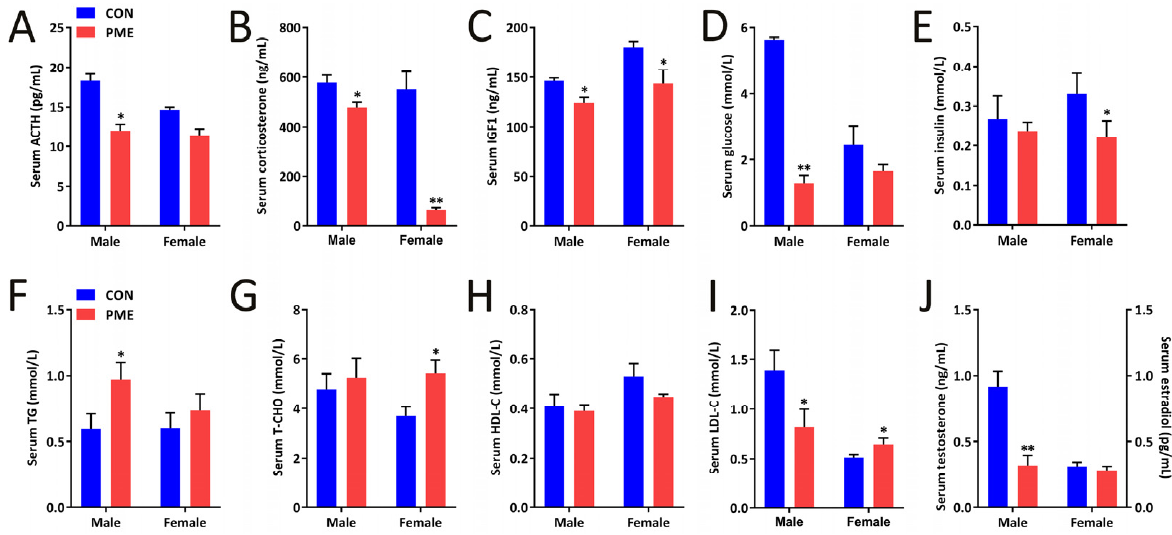
Figure 5. Impairments of paternal mixed exposure (PME) on HPA axis activity, glucolipid metabolism, and sex hormone levels in offspring. ( A ) Serum ACTH content. ( B ) Serum corticosterone content. ( C ) Serum IGF1 content. ( D – I ) Levels of serum glucolipid metabolism indicators, including glucose ( D ), insulin ( E ), TG ( F ), T-CHO ( G ), HDL-c ( H ), and LDL-c ( I ). ( J ) Serum testosterone and estradiol contents. Means ± S.E.M., n = 10 * p < 0.05, ** p < 0.01 vs. CON (control). Table 1. Correlation analyses among fetal serum corticosterone level, fetal body weight, body length, and serum IGF1 level in control and PME groups.